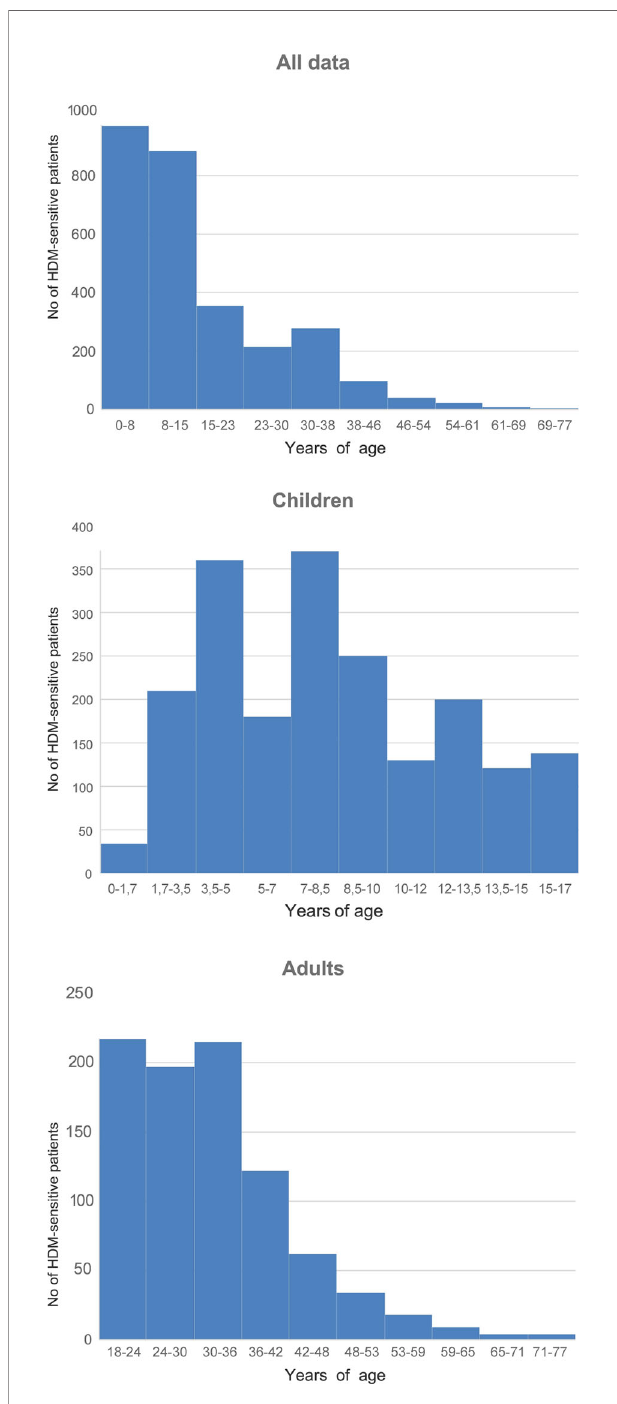
FIGURE 1 | Range of the studied subjects by age. Mean tIgE of sensitized group was 332.82 ± 17.28 kU/l, to Der p 2 it was 25.97 ± 17.26 kU/L. These values were the highest in data series of mean sIgE-s for both children and adults. Der p 21 was the third by the mean sIgE for general cohort and for children and adults too (19.7 ± 17.28 kU/L, 22.10 ± 16.75